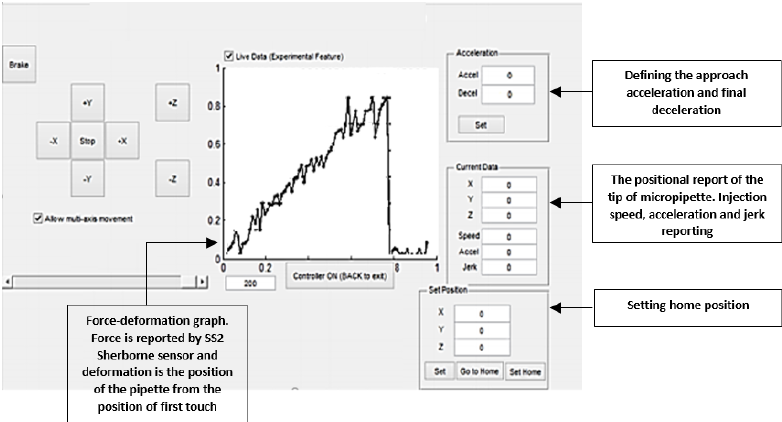
Figure 2. Graphical user interface for the injection